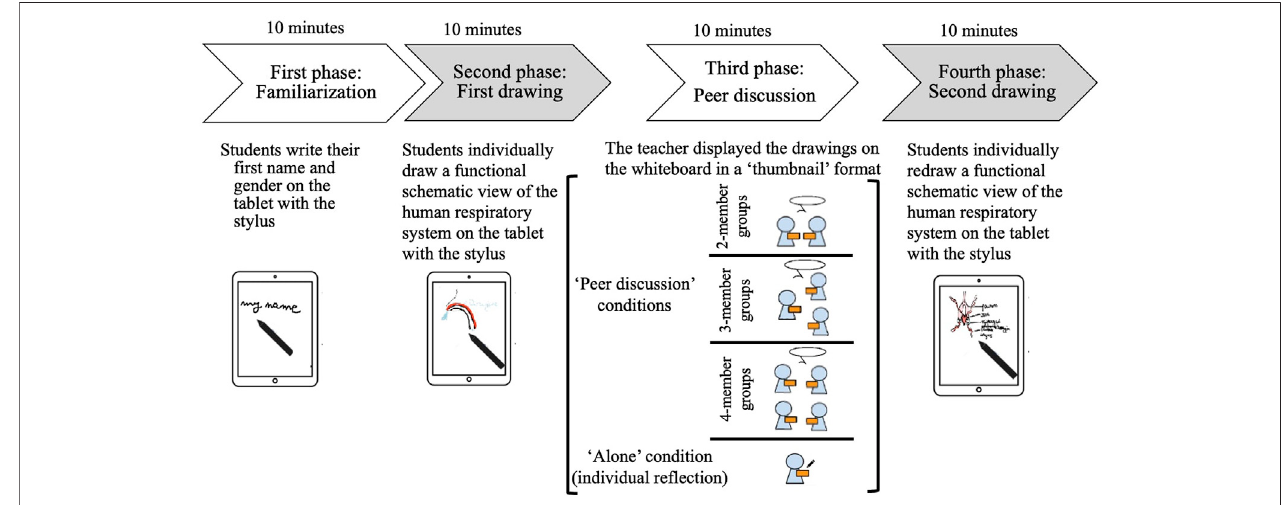
FIGURE 1 | Overview of the